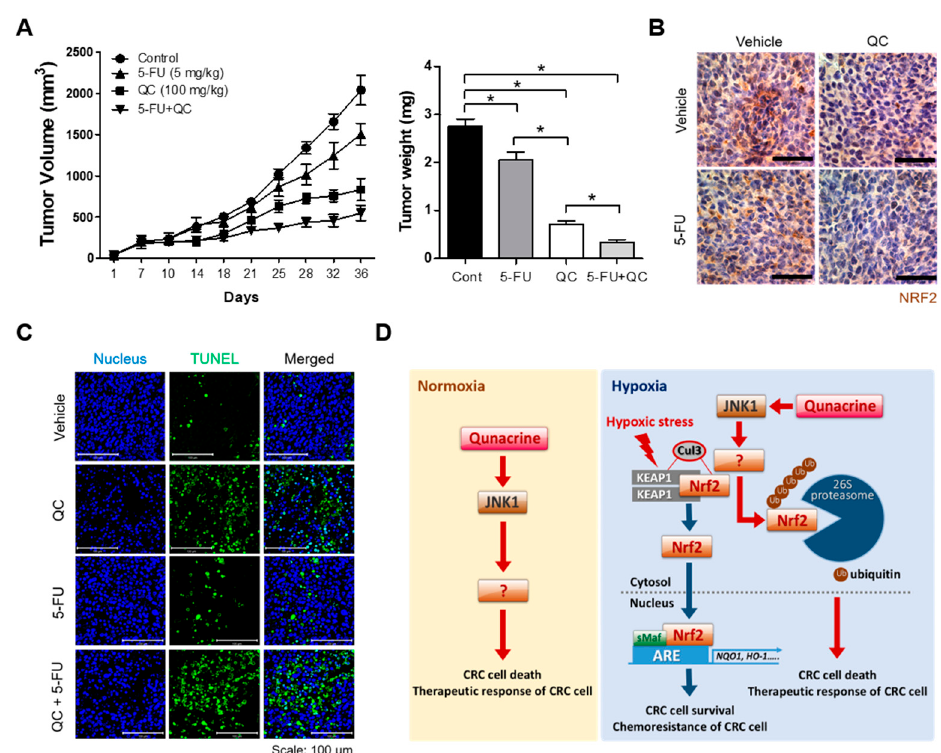
Figure 5. The QC / 5-FU combination inhibits tumor growth in a tumor xenograft mouse model. ( A ) Tumor volume was measured at the indicated times (left panel), and tumor weight was quantified at the end of the experiment (right panel). Data are presented as means ± SEM ( n = 7 mice / group; * p < 0.05). ( B ) Representative images of immunohistochemical analyses of Nrf2 in tumors derived from HCT116 xenografts. Scale bar = 50 µ m. ( C ) Apoptotic cells were detected in HCT116 xenograft tumors using a TUNEL (terminal deoxynucleotidyl transferase dUTP nick end labeling) assay kit. Scale bar = 100 µ m. Blue, nuclei; green, TUNEL staining. ( D ) Schematic model showing how QC reverses hypoxia-induced 5-FU resistance in CRC cells under normoxia and hypoxia by inhibiting Nrf2.